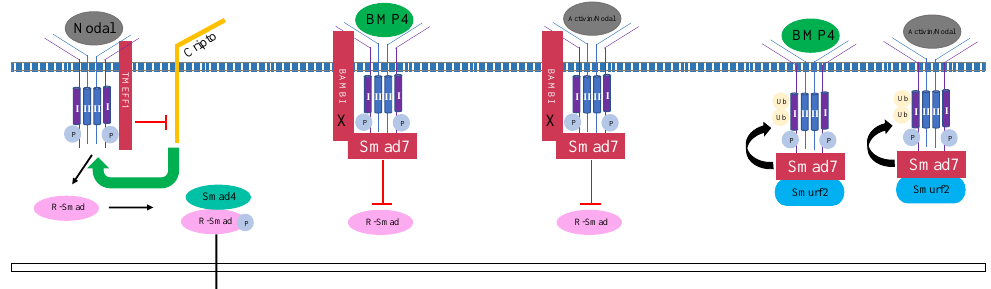
Figure 3. Transmembrane and cytosolic inhibition of mesendodermal gene expression. TMEFF1, a transmembrane protein, prevents the association between Cripto, a Nodal-pathway specific coreceptor, and the type I receptor. Smad7 inhibits TGF β signaling by forming a complex with Smurf2, which subsequently induces the degradation of the type I and type II TGF β receptors. BAMBI, another transmembrane protein, associates with Smad7 and the type I receptor and inhibits association between the type I receptor and R-Smads. The “X” indicates the lack of a serine / threonine intracellular kinase domain.